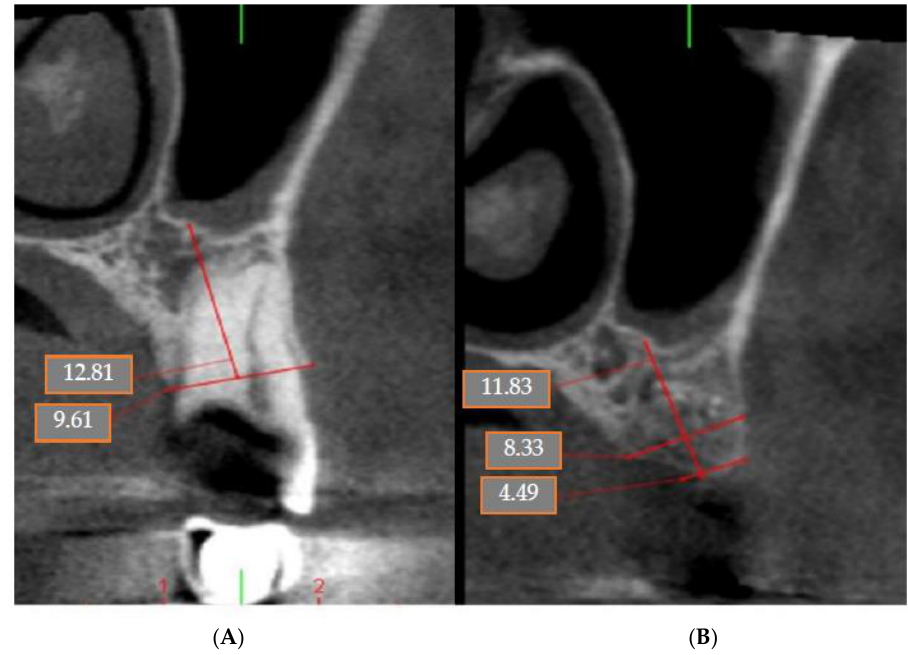
Figure 6. ( A ) Previous CBCT; ( B ) CBCT after 4 months.